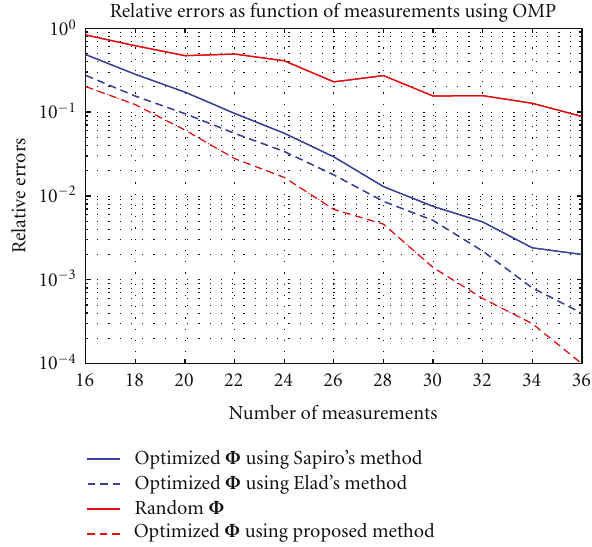
Figure 2: CS relative errors as function of the number of measurements using OMP.